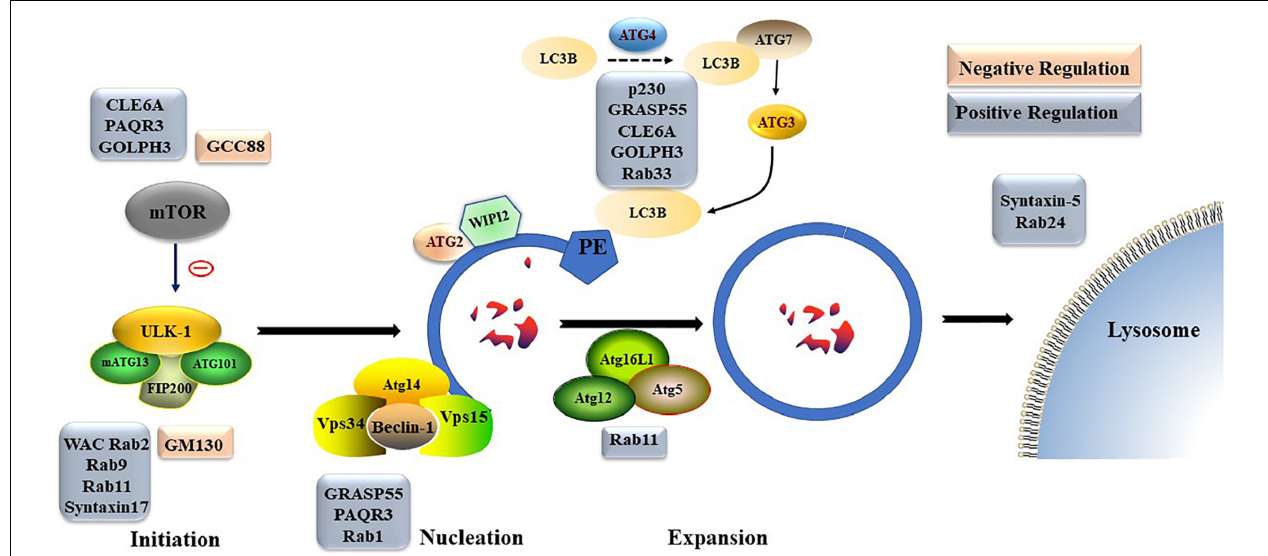
FIGURE 4 | The detailed regulation mechanisms of Golgi proteins involved in autophagosome formation.